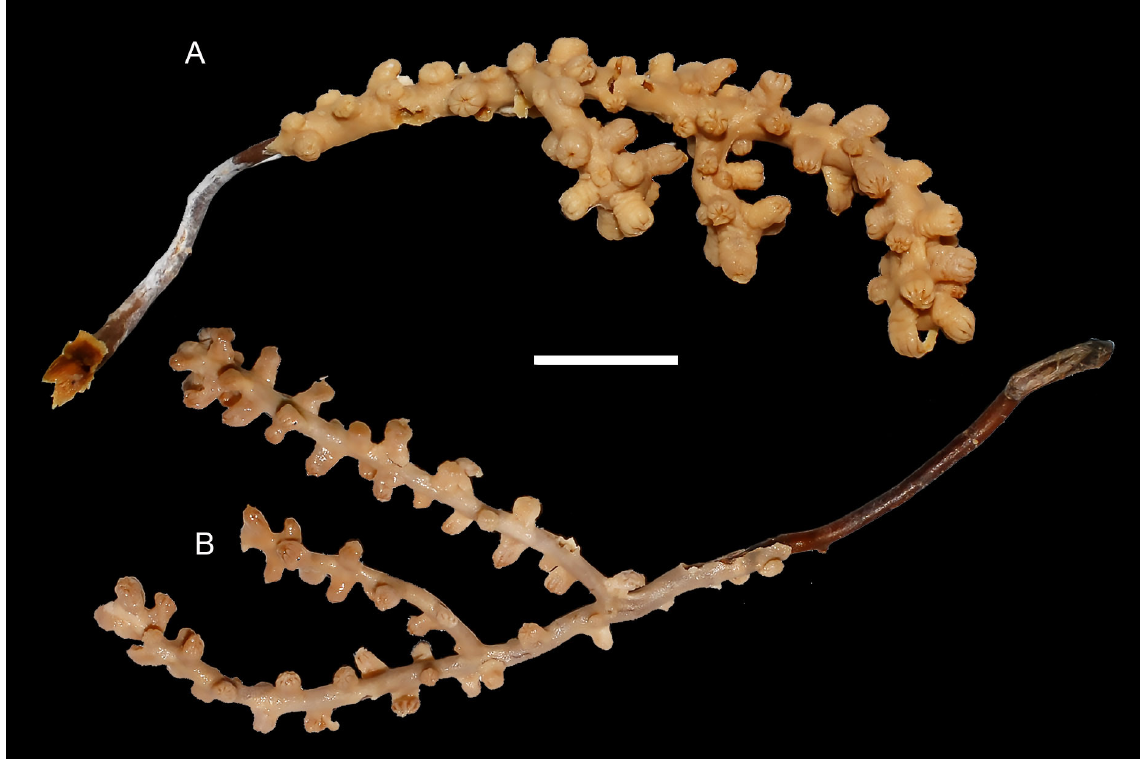
Fig. 1. Calcigorgia matua sp. nov. A . Holotype (MIMB 20722), Kurile Islands, Sea of Okhotsk. B . Paratype (MIMB 20724), Kurile Islands, Sea of Okhotsk. Scale bar: 10